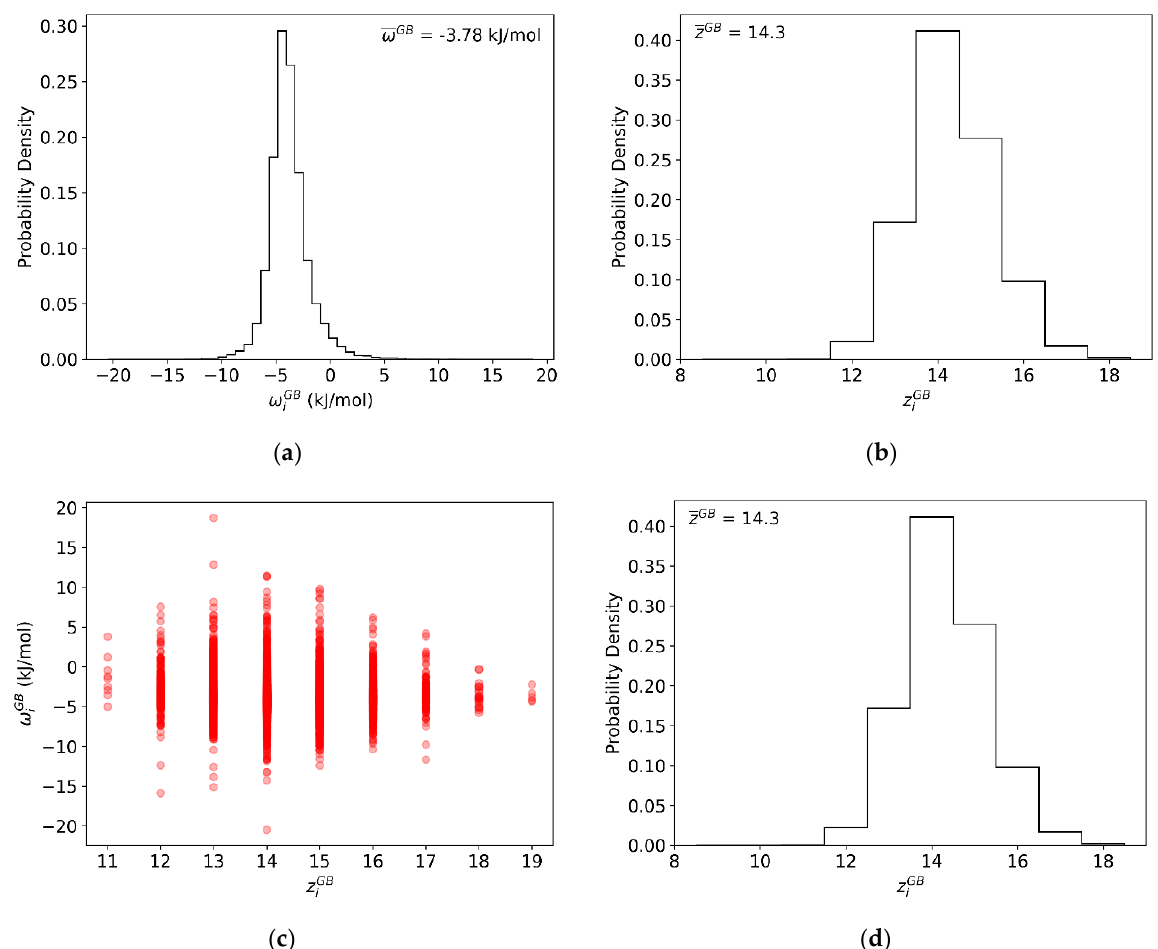
Figure 6. For every GB site in the (10 nm) 3 Al-Mg polycrystal: ( a ) Atomic coordination of every GB site. ( b ) Correlation plot of atomic coordination and per-site parameter 𝑤 𝑖𝐺𝐵 . ( c ) Average per-site parameter 𝑤 𝑖𝐺𝐵 . ( d ) Average per-site heat of mixing parameter 𝛺 𝑖𝐺𝐵 .